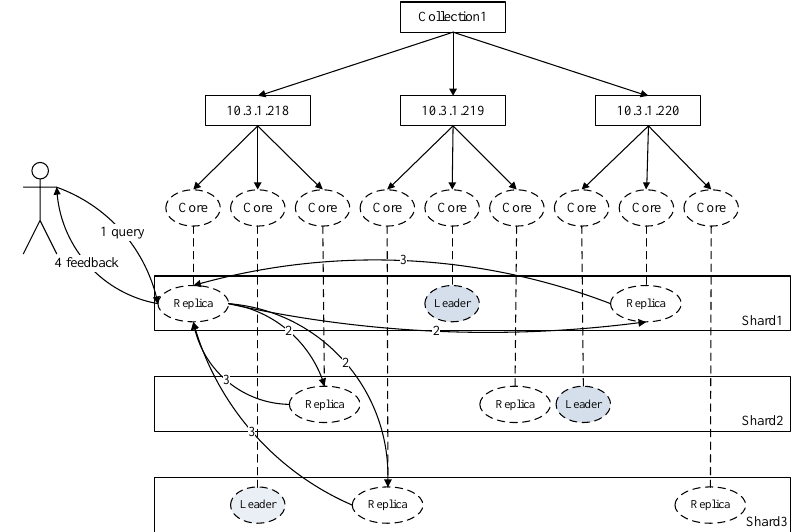
Figure 7. The SolrCloud distributed query process. (1) The user’s data query request is sent to any one of the SolrCloud nodes, and then forwarded to one of the replication nodes; (2) The distributed query is launched and converted into multiple sub-queries, each of which is located on any of the replications; (3) Results are returned by each sub-query; and (4) sub-query results are merged and returned to